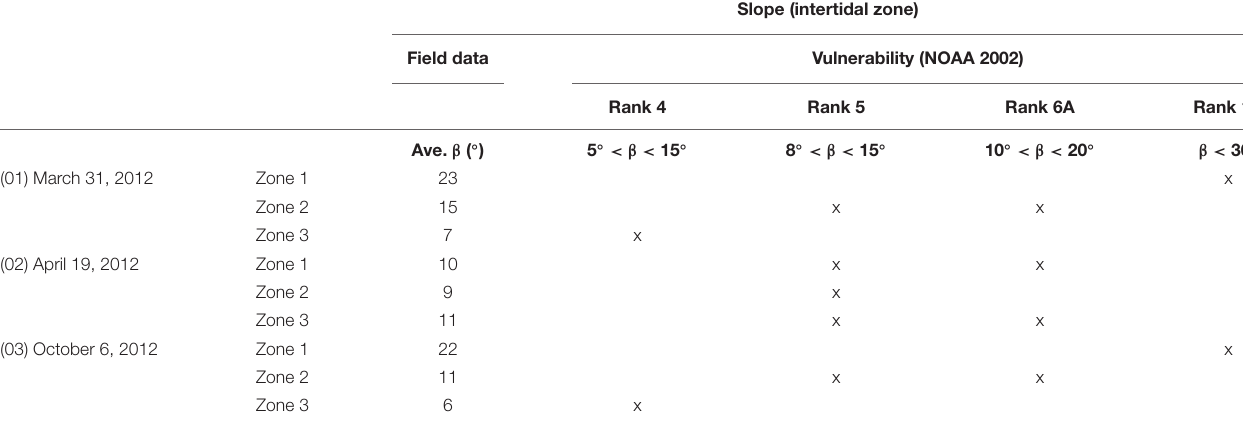
TABLE 4 | The National Oceanic and Atmospheric Administration [NOAA] (2002) classification for Sirolo according to previous slope